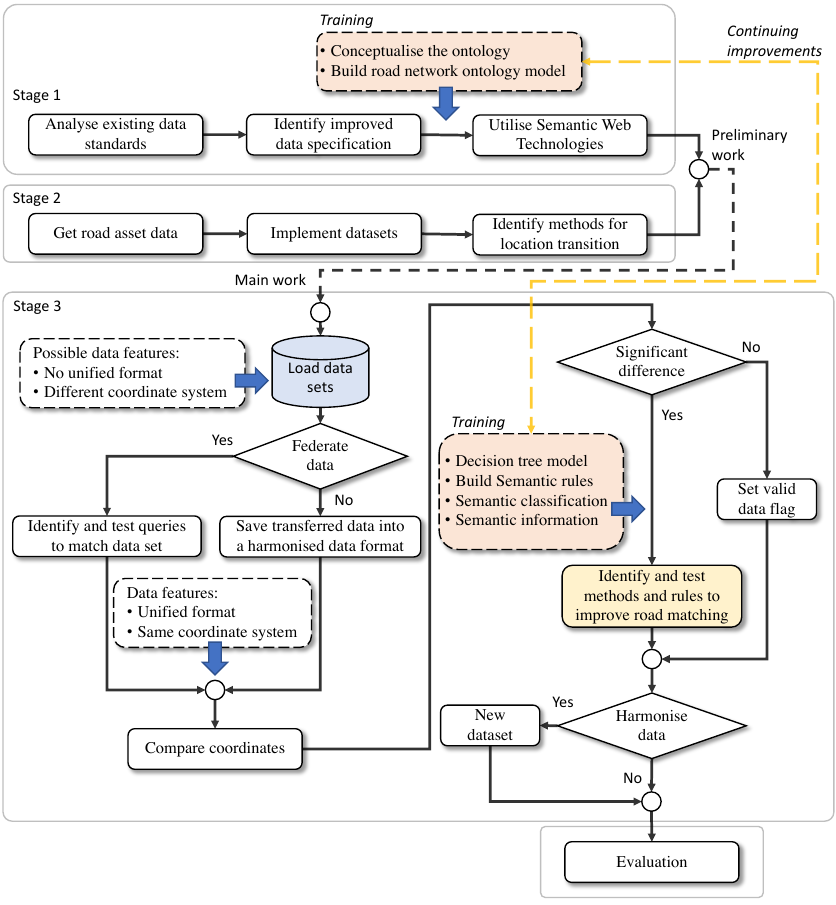
Figure 1. The workflow of this strategy is subdivided into three stages. The yellow box represents the primary task of this research and is connected to the training techniques in the orange boxes. The training symbolises testing of new semantic rules and decisions which flow as improvements back into the